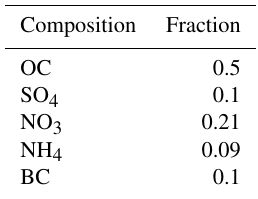
Table 3. Volume fraction of aerosols included in SALSA for all simulations in case 2 and case